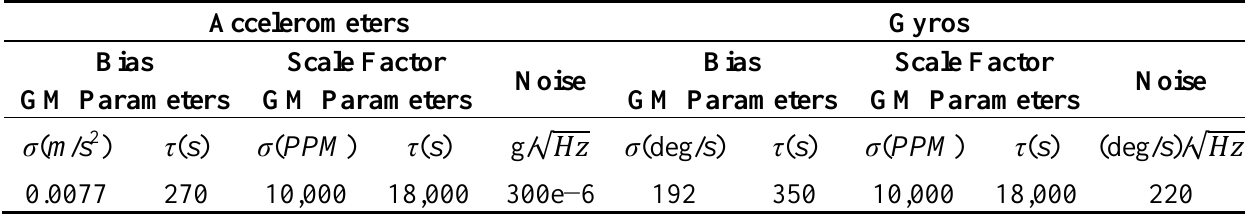
Table 2. Crista IMU random noise spectral density and Gauss-Markov